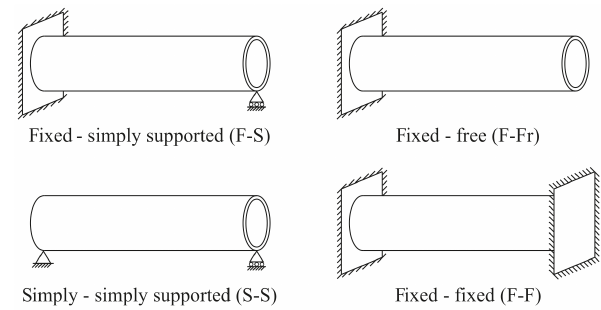
Figure 2. The applied boundary conditions on